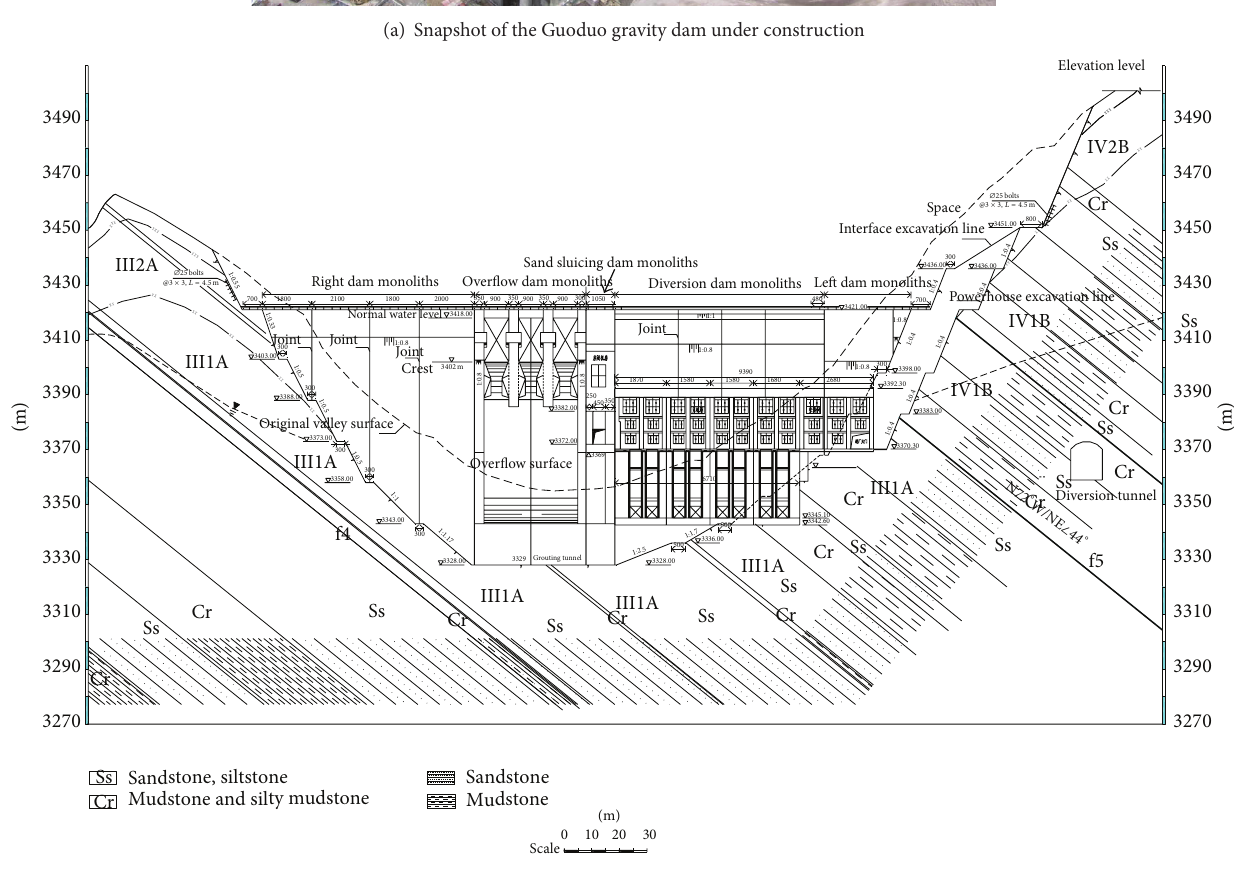
Figure 1: Geoconditions and vertical profile of the Gouduo gravity